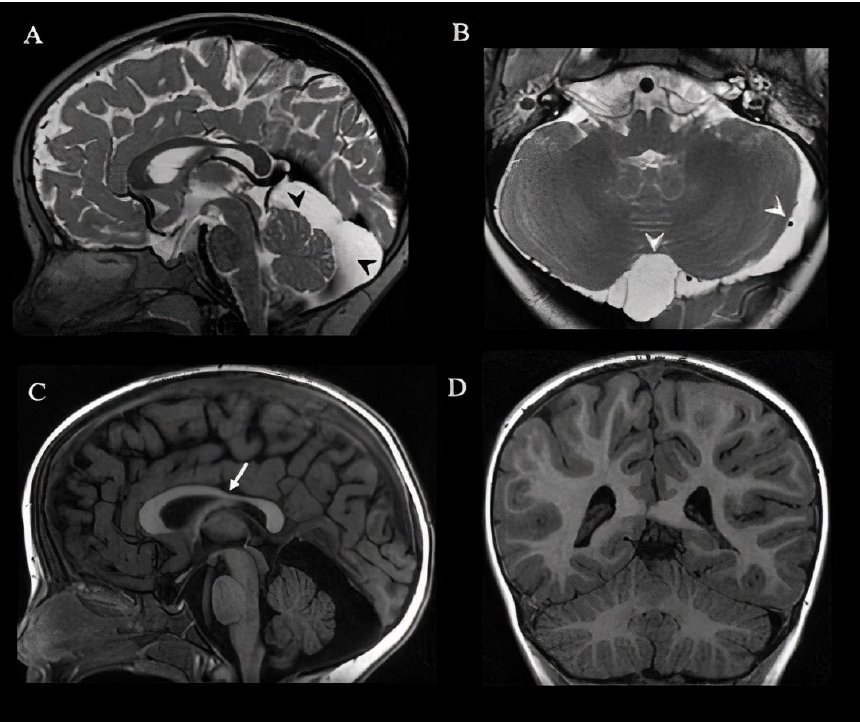
Figure 1. Brain MRI of a 3.5-year-old girl. Sagittal ( A ) and axial T2 weighted images ( B ) show en- larged retrovermian cistern and left pericerebellar subarachnoid space (black and white arrowheads). Sagittal T1 weighted image ( C ) shows thinning of the isthmus of the corpus callosum (white arrow). Sagittal ( A , C ) and axial ( D ) images show a normal conformation of the cerebellar hemispheres and vermis. MRI remained unchanged in comparison with the previous one performed at the age of 2.4 years old, except for a progression of the